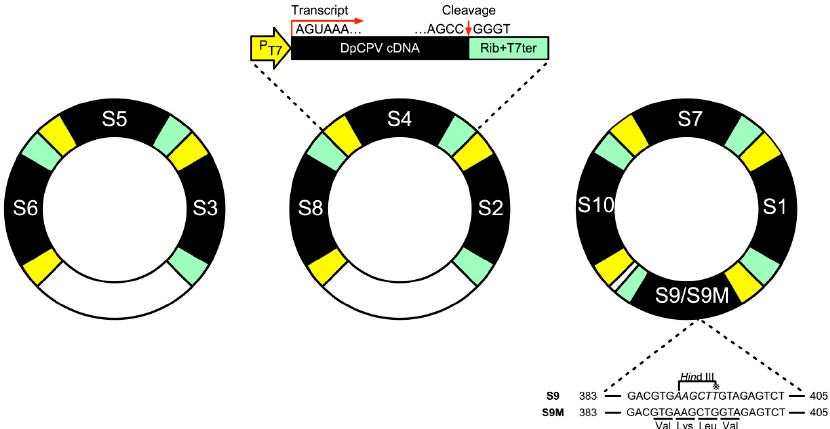
Figure 3. Schematic representation of the reverse genetics vectors containing cDNAs derived from Dendrolimus punctatus cypovirus (DpCPV) RNA segments. Three or four gene transcription cassettes encoding DpCPV cDNAs flanked by the T7 RNA polymerase promoter and an HDV Rib and T7 RNA polymerase terminator cassette were combined into single plasmids, creating three constructs for the reverse genetics systems of rDpCPV or rDpCPV-S9M (see Figure S1C). The single nucleotide difference in S9 unique to rDpCPV-S9M and DpCPV is shown in the alignment as an asterisk. The T/G substitution at position 395 was a deliberate change engineered into the cloned DpCPV S9 cDNA fragment used as a marker for